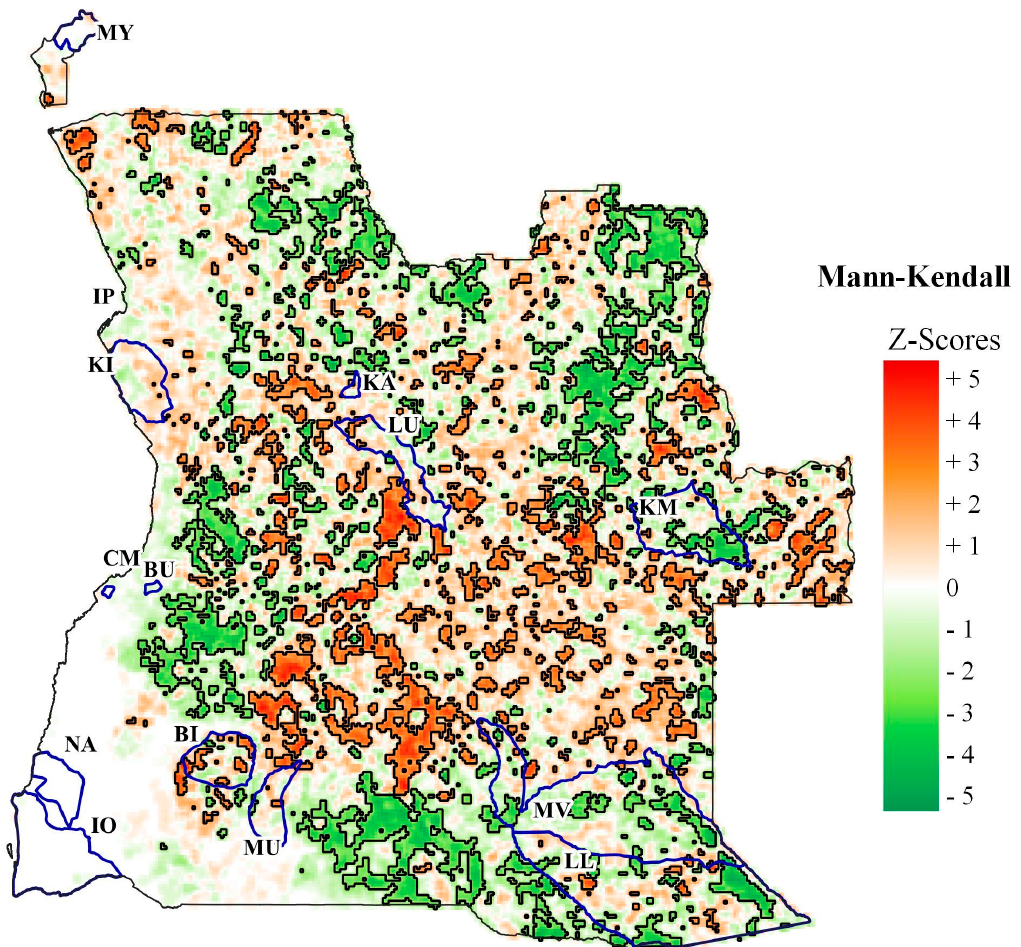
Figure 4. Trends of the annual burnt area in Angola for the 2001–2019 period, based on the contextual Mann–Kendall test. The positive z-scores correspond to areas of increasing trends of burnt area, while the negative z-scores correspond to decreasing trends. The significant areas (with a confidence level of 95%) were outlined with black lines. Protected areas are indicated with blue outlines: BI, Bicuar; BU, B ú falo; KA, Cangandala; CM, Chimalavera; IO, Iona; IP, Ilheu dos P á ssaros; KM, Cameia; KI,